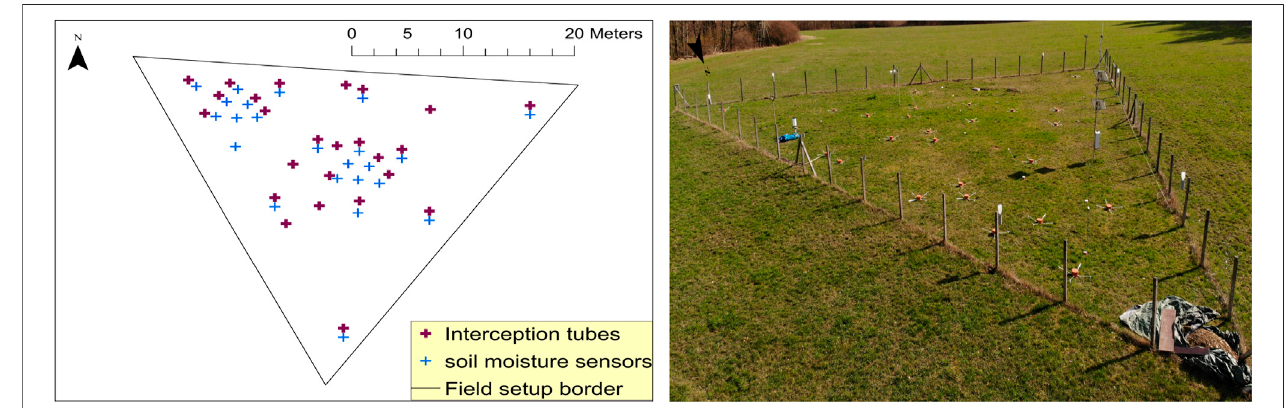
FIGURE 3 | Overview of the fi eld setup. (left) Map of the location of the interception tubes and soil moisture sensors. (right) A photograph from a drone in the uncovered period in March 2019.